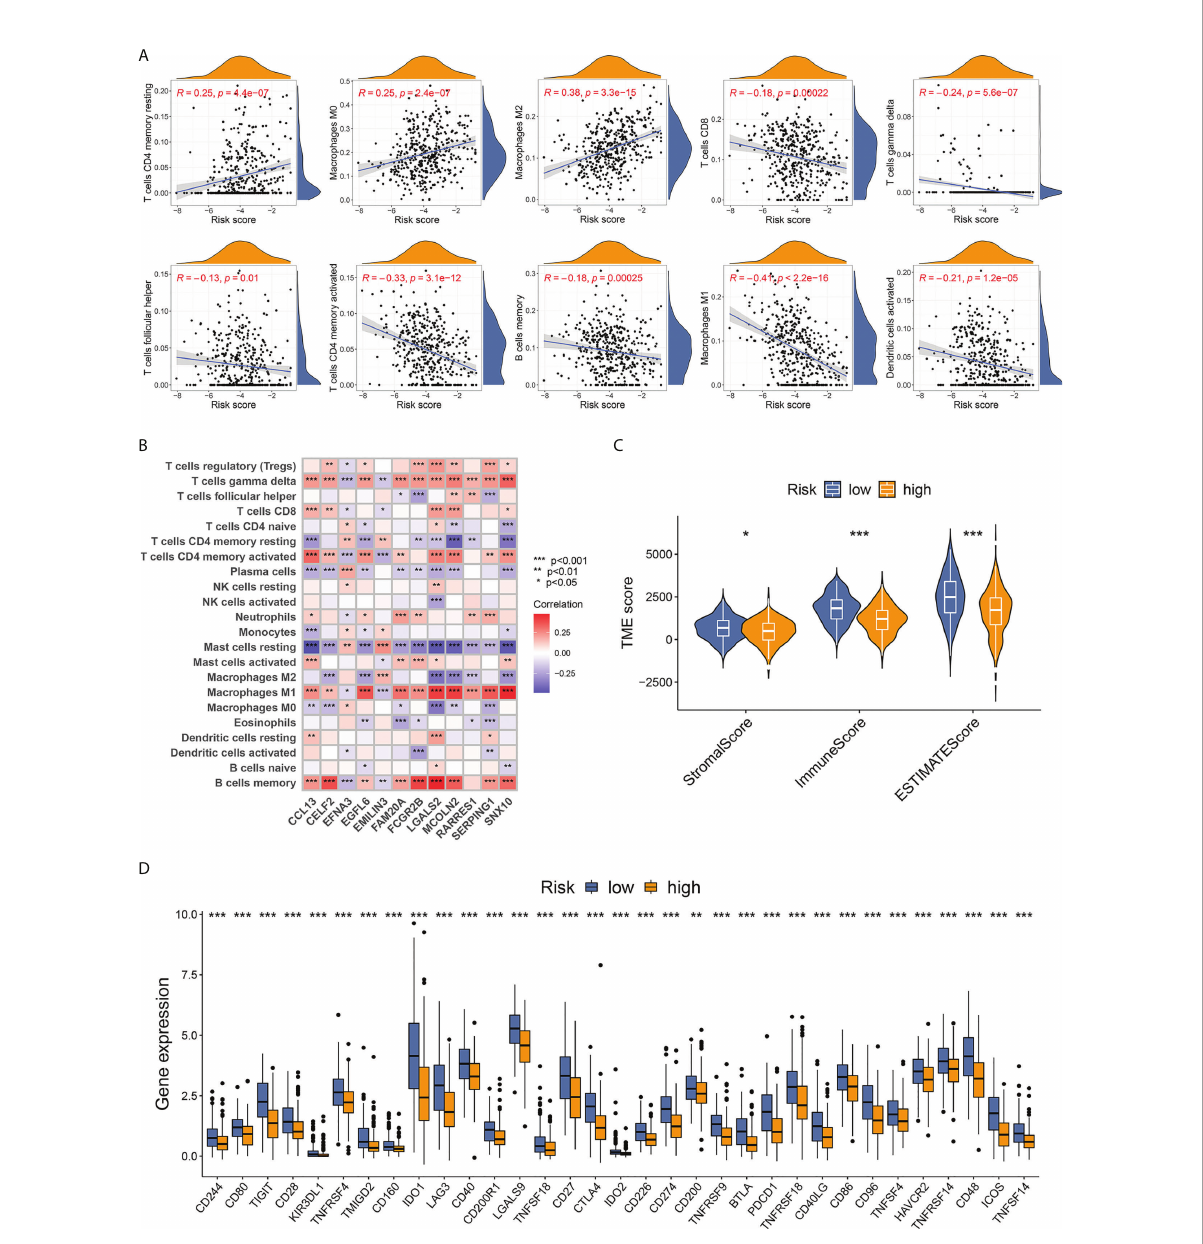
FIGURE 6 Evaluation of TME features based on the 12-DEG risk score. (A) Correlation between immune cell in fi ltrating fractions and the 12-DEG-based risk scores in TNBC samples. (B) Correlation between the 12 DEGs from the scoring system and the abundance of 22 analyzed immune cell types. (C) TNBC samples from low-risk patients showed higher stromal, immune, and ESTIMATE scores, indicating lower tumor purity with more stromal cells and immune cells in TME. (D) A total of 33 immune checkpoints were upregulated in low-risk TNBC patients. * p < 0.05, ** p < 0.01, ***